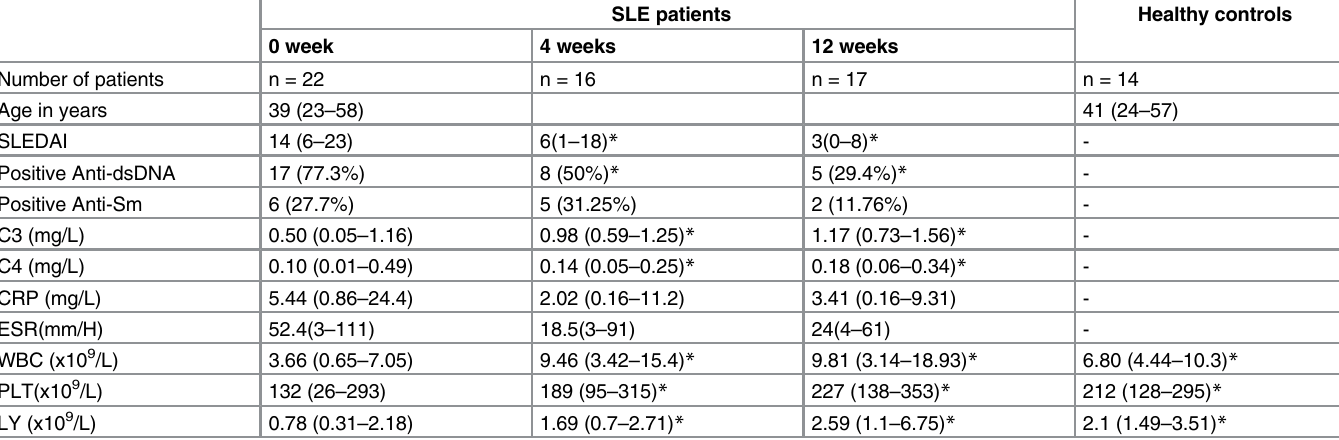
Table 1. Demographic and clinical parameters of study participants.